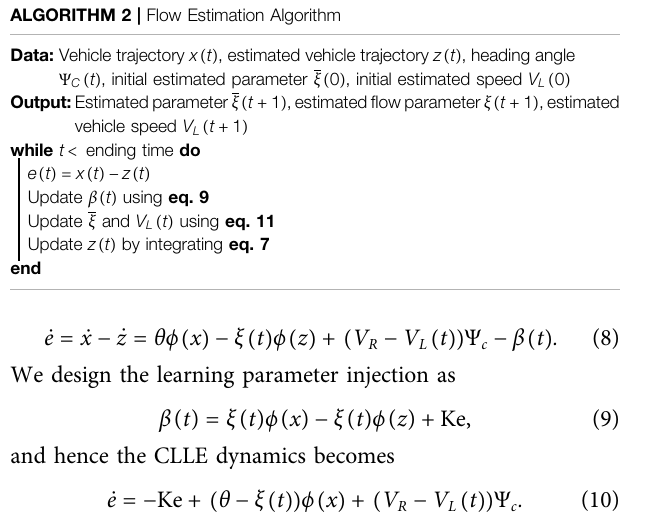
ALGORITHM 2 | Flow Estimation Algorithm